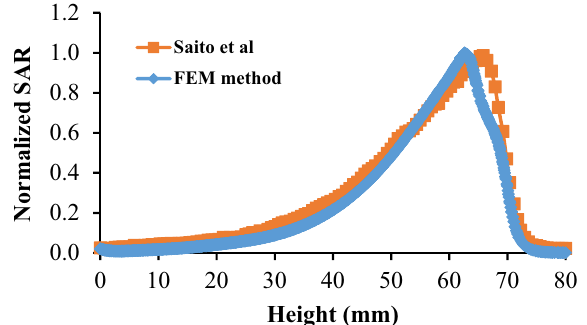
Figure 3. A comparison between SAR quantity calculated by Saito et al. 23 , and present model by FEM method.